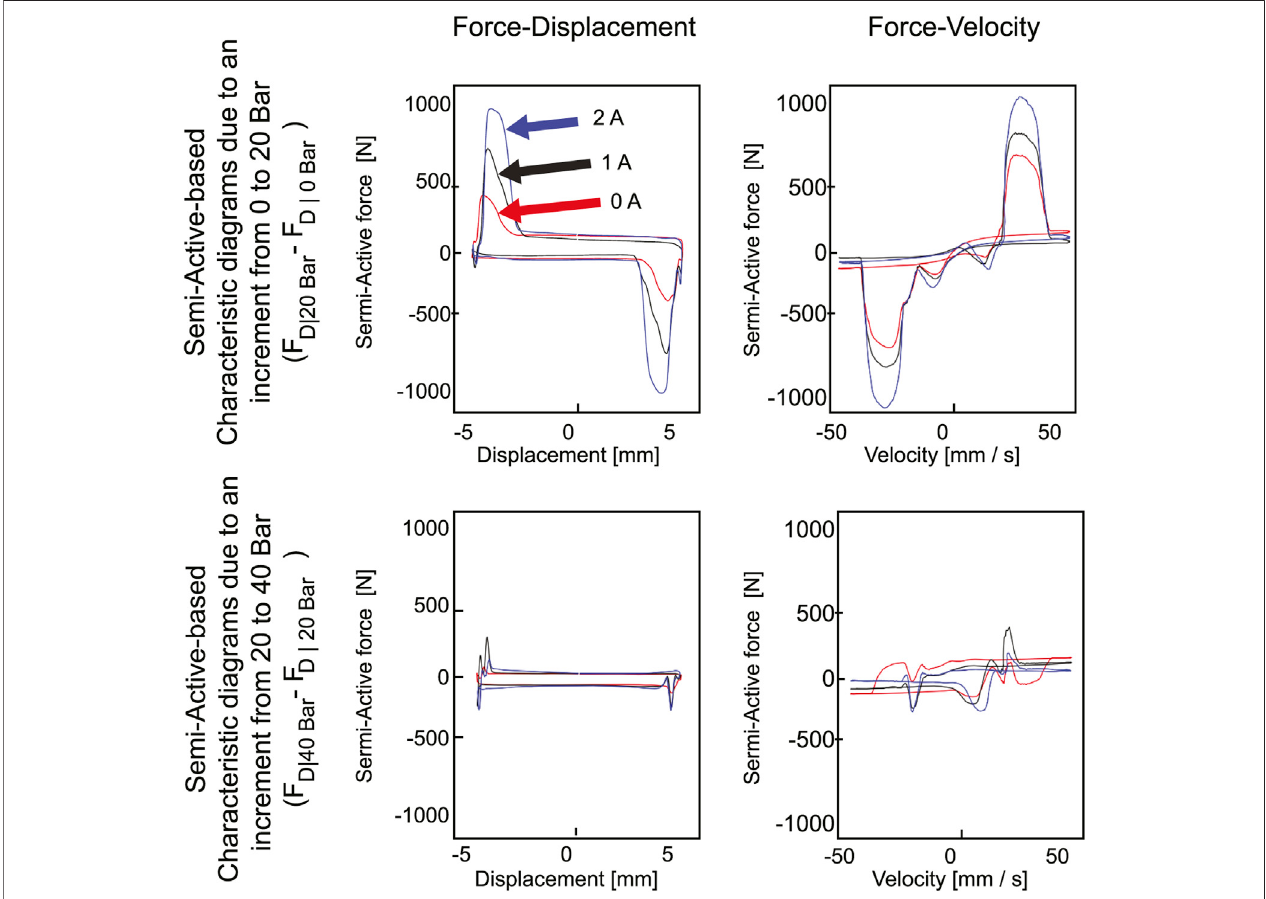
FIGURE 17 | Characteristic diagrams of the semi-active force generated by the constant increments of the pressure according to the proposed method.